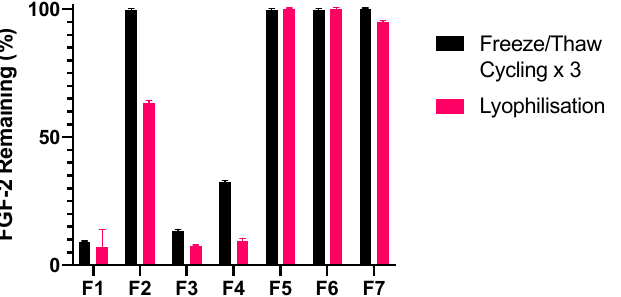
Figure 8. Effect of excipients on the stability of FGF-2 aqueous solutions (770 ng/mL) exposed to processing stressors. Solutions were subject to three freeze/thaw cycles or lyophilisation, and the residual FGF-2 content was measured by ELISA and expressed as a percentage of the baseline concentration (mean ± SD, n = 3). Sample abbreviations: F1, FGF-2 in water; F2, FGF-2 and 0.05% w/v methylcellulose (MC) in water; F3, FGF-2 and 20 mM alanine in water; F4, FGF-2 and human serum albumin (HSA) in water; F5, FGF-2, 0.05% w/v MC and 20 mM alanine in water; F6, FGF-2, 0.05% w/v MC and 1 mg/mL HSA in water; and F7, FGF-2, 0.05% w/v MC, 20 mM alanine and 1 mg/mL HSA in water.